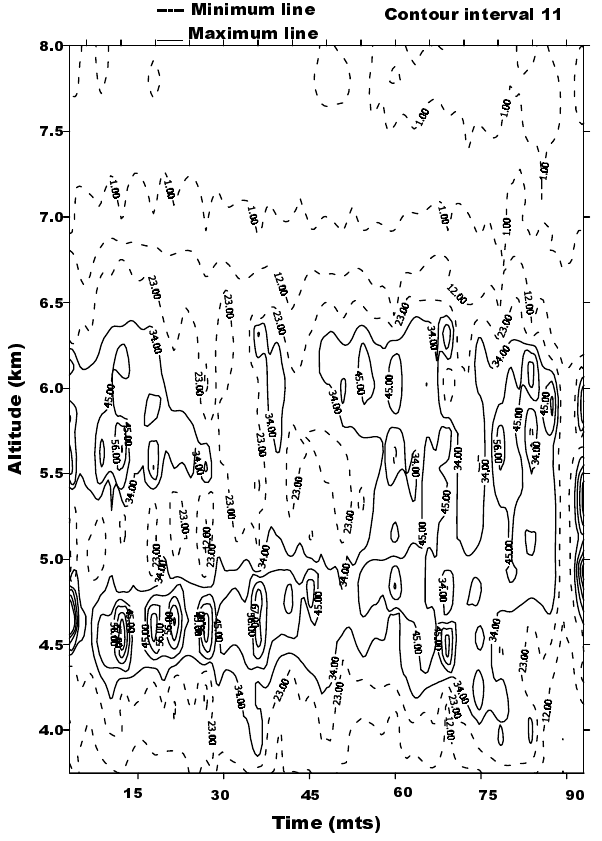
Fig. 6. Evolution of reflectivity (arbitrary unit) during convection event on 28 August 1999: during 13:00 to 14:30LT.